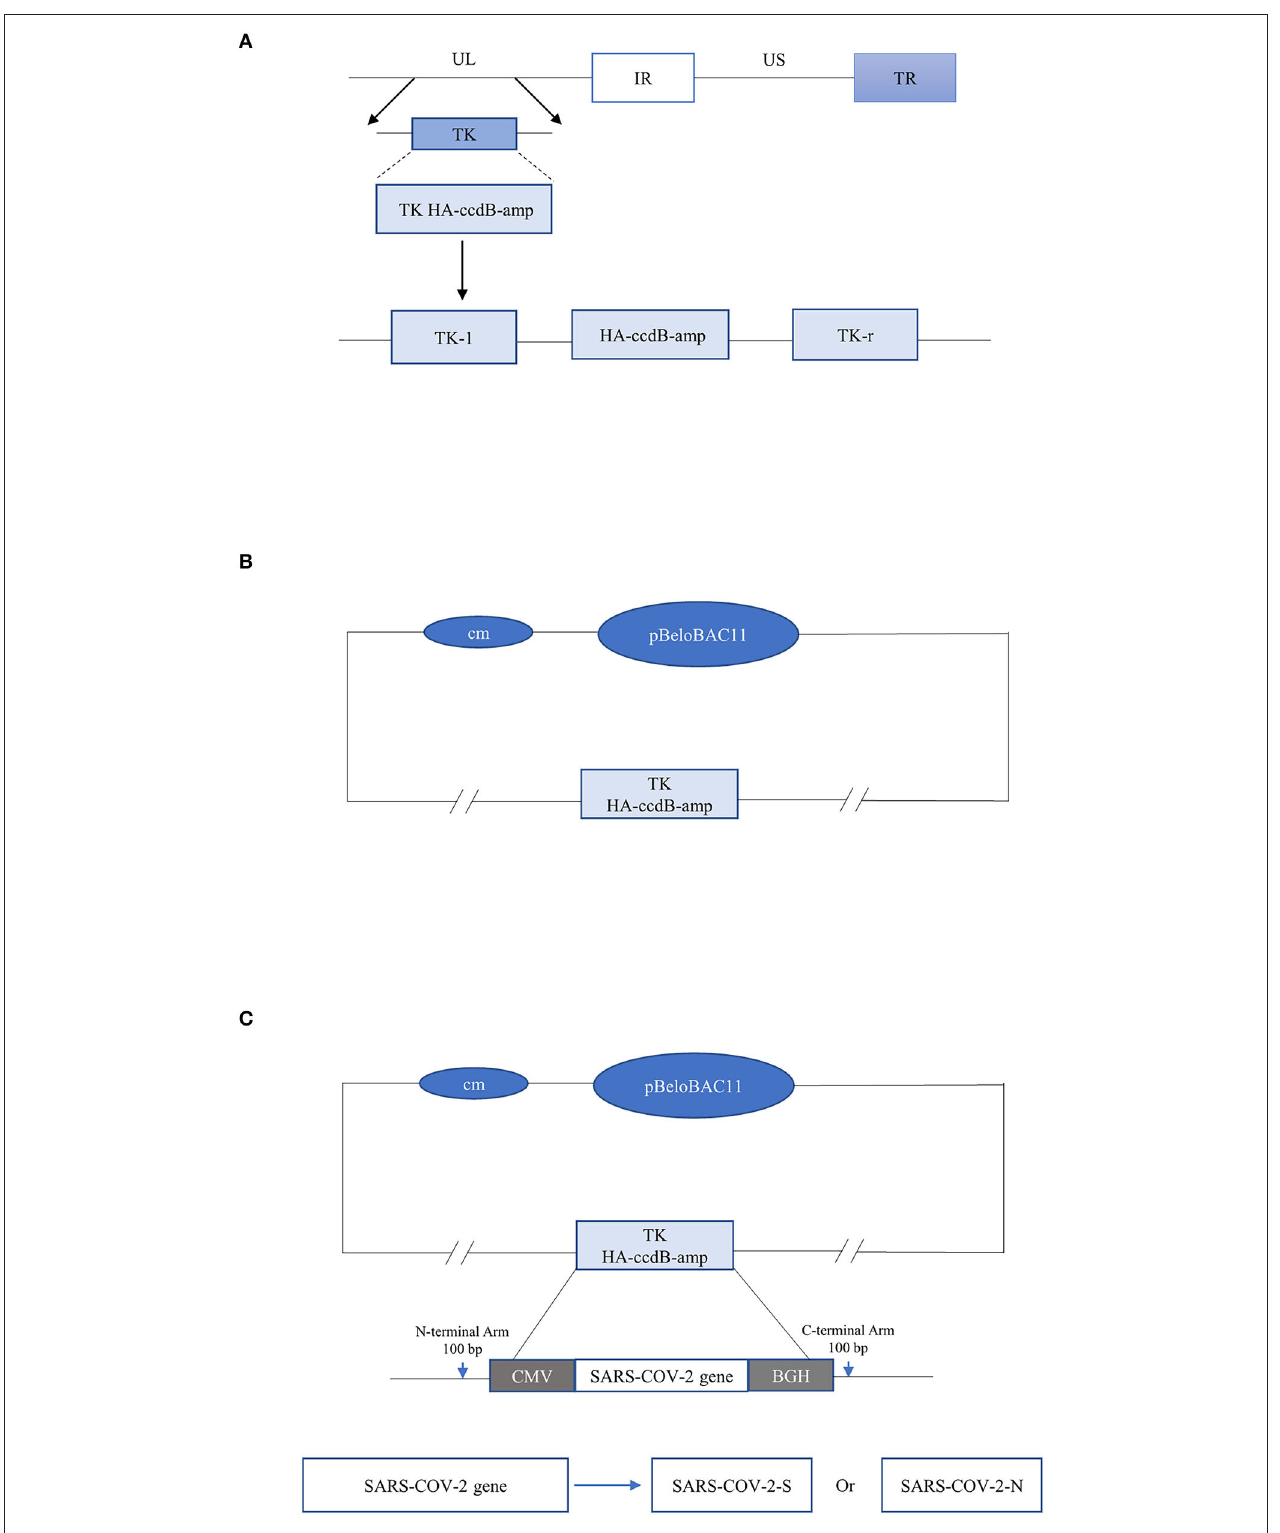
FIGURE 1 | (A) The selectable gene TK HA-ccdB-amp containing the homologous arm of TK gene of PRV vaccine Strain Bartha-K61 was amplified by PCR. (B) In the first step, the selectable gene TK HA-ccdB-amp, and plasmid pBeloBAC-PRV-Bartha-K61 were recombinant by the Red/ET recombination technique. The TK site of the Bartha-K61 strain was replaced with the selectable gene. (C) In the second step, the gene SARS-CoV-2-S and SARS-CoV-2-N were recombined with pBeloBAC-PRV-Bartha-K61, respectively, and then inserted at the TK site, driven by the CMV promoter and ended by BGH termination signal. Finally, the TK site was replaced with SARS-CoV-2-S and